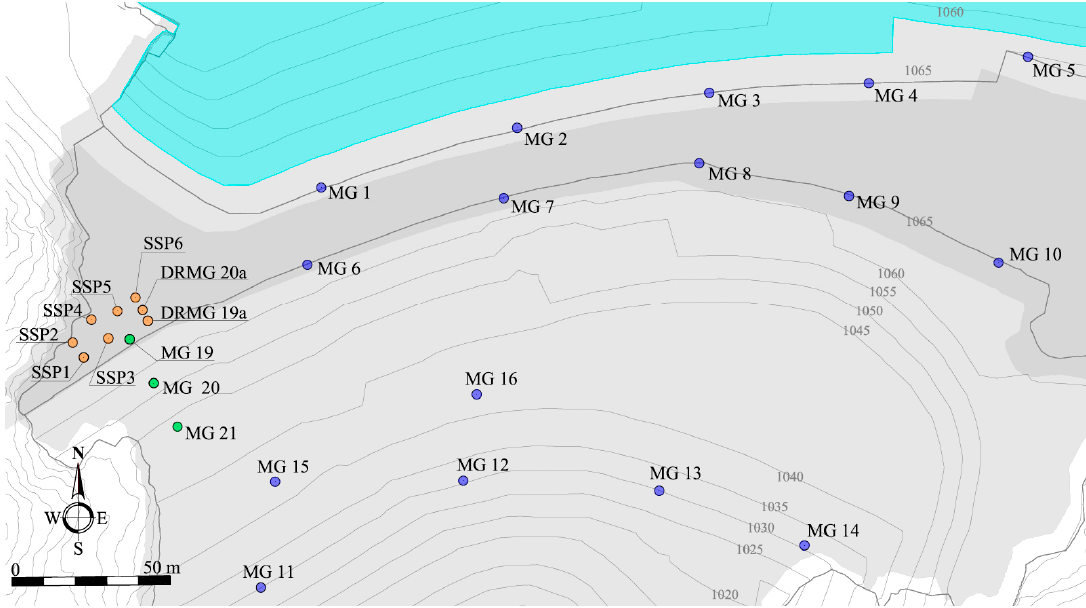
Figure 1. The monitoring area with observational points alongside the crest (points MG1-MG10, points SSP1 to SSP5, points MG19 to MG21, DRMG19a and DRMG20a) and on the cofferdam body (points MG11 to MG16).